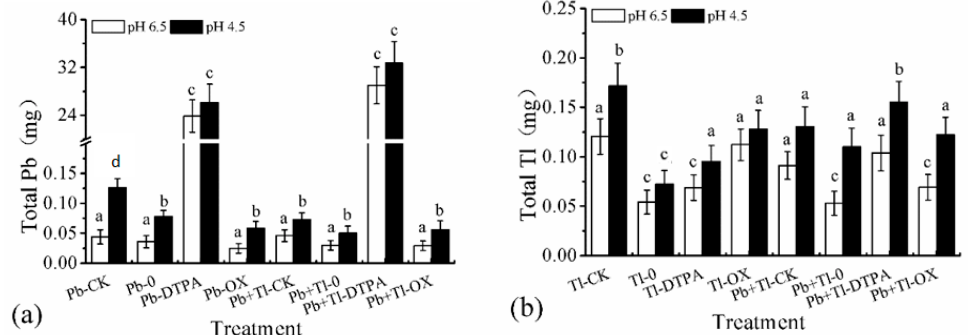
Figure 1. Cumulative Pb ( a ) and Tl ( b ) leached from soil by di ff erent treatments in leaching experiment. Error bars are the standard deviation (SD) ( n = 3). Pb, Tl, and Pb + Tl indicate the types of heavy metal contaminations. CK = no maize; 0 = no chelating agents; DTPA = 2.5 mmol kg − 1 soil; oxalic acid = 2.5 mmol kg − 1 soil. Di ff erent superscript letters indicate a significant di ff erence ( p < 0.05).